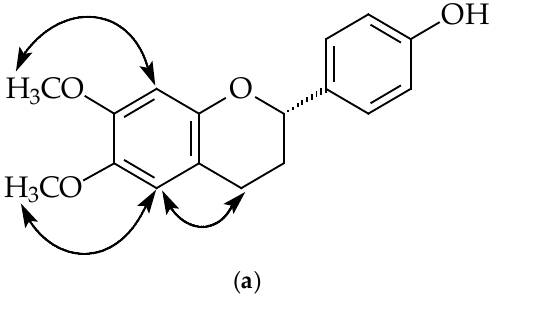
Figure 2. Key NOESY contacts ( a ) and HMBC connectivities ( b ) of compound 1 .